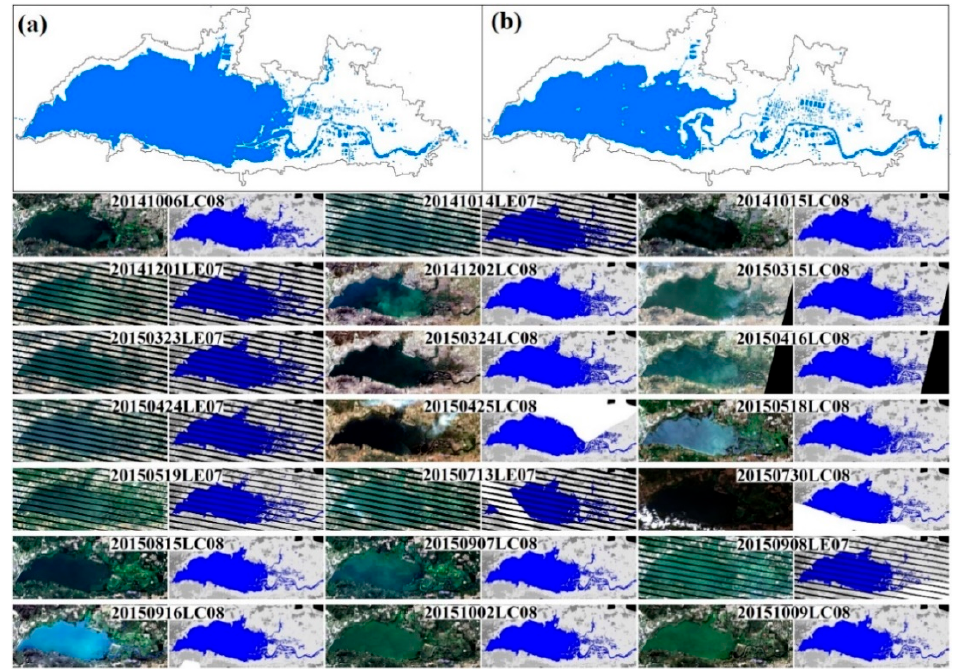
Figure 10. The maximum water frequency maps of YR for IWCT result ( a ) and GSWD result ( b ). The rest images are the Table 2014. to October 2015.